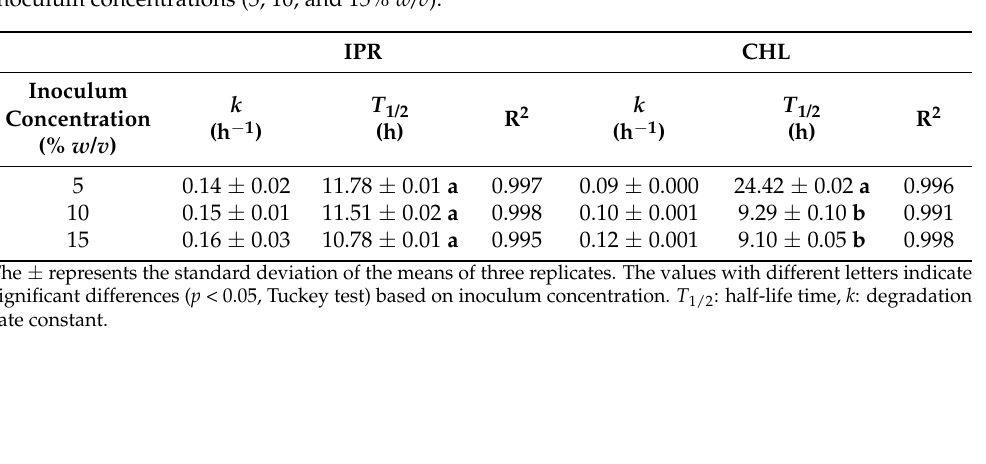
Table 3. First-order kinetics parameters for iprodione (IPR) and chlorpyrifos (CHL) removal at a concentration of 50 mg L − 1 each, inoculated with the immobilized bacterial consortium at different inoculum concentrations (5, 10, and 15% w/v